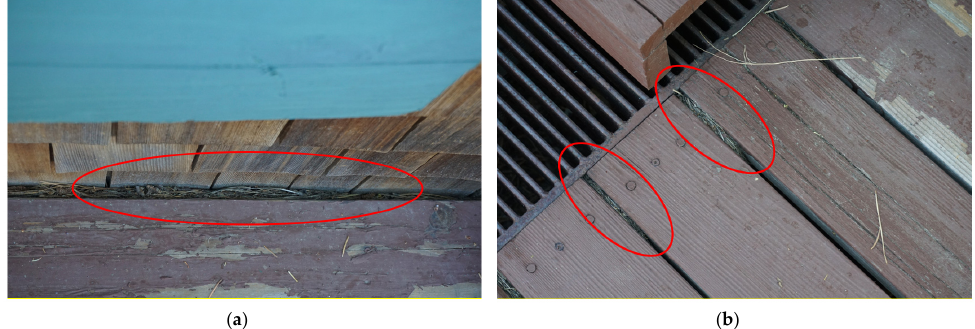
Figure 10. ( a ) Deck to wall connection, with accumulation of vegetative debris in gap between deck and vertical wall. ( b ) Debris accumulation in the gap between deck boards[4].